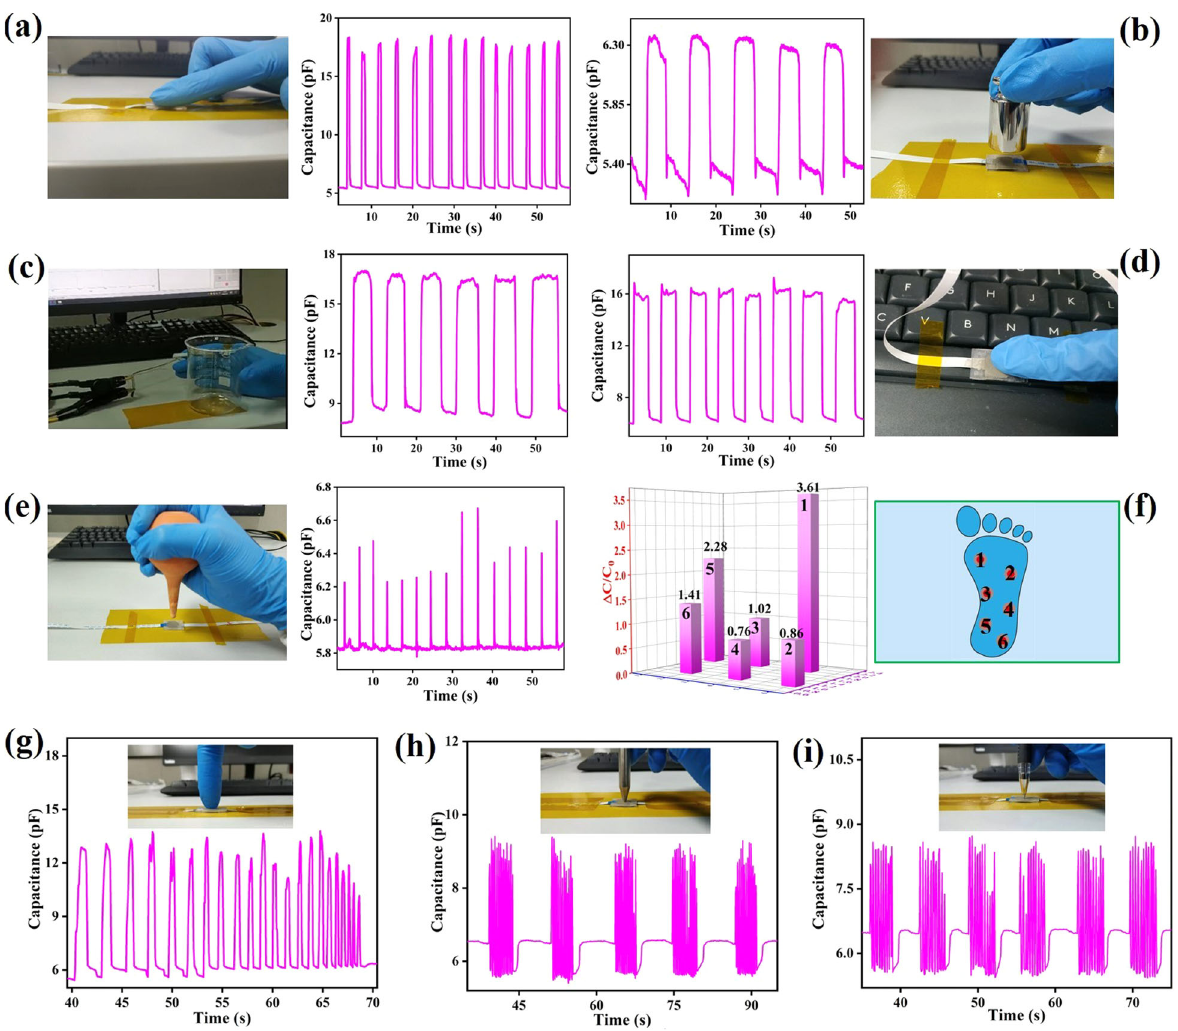
Fig. 6 Demonstration of the micro-structured sensor in response to exerted pressures. a , b Capacitance response of the sensor to quick touching and weight pressuring; c – e Detection of various repeated actions, including grasping the beaker, knocking the keyboard, and blowing air; f Foot pressure distribution identi fi ed by a sensor array; g – i Detection of the repeated strikes of the sensor by the fi ngertip, stainless cone, and pen